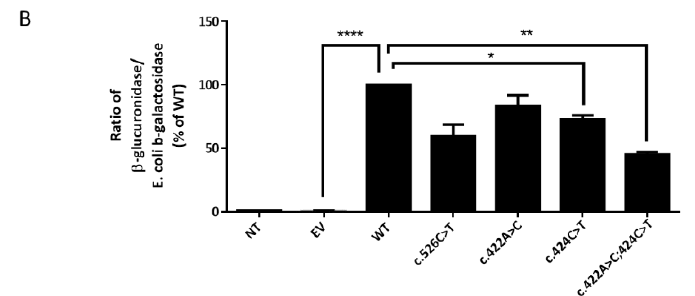
Figure 3. Effects of GUSB mutations on GUSB expression and enzyme activity. HEK293T cells were transfected or not (NT) with an empty vector (EV) or a vector containing the cDNA encoding either the wild-type (WT) or the indicated mutant GUSB. Forty-eight hours after transfection, cells were harvested and cell lysates were prepared. ( A ) Protein expression of GUSB. Lysates (30 µg protein) were analyzed for GUSB expression by Western-blot. The blot is representative of three independent experiments. ( B ) Enzymatic activity of GUSB in transfected HEK293T cells. GUSB and Escherichia coli β-galactosidase activities were measured in cell lysates. The ratio of GUSB/ E. coli β-galactosidase activities (means +/− SEM of three independent experiments) is presented as a percentage of the values recorded in cells overexpressing the WT GUSB. The basal enzyme activity of GUSB in non-transfected cells averaged 30 nmol/h/mg protein. Asterisks indicate statistically significant difference: *, p < 0.05; **, p < 0.01; ****, p < 0.0001.